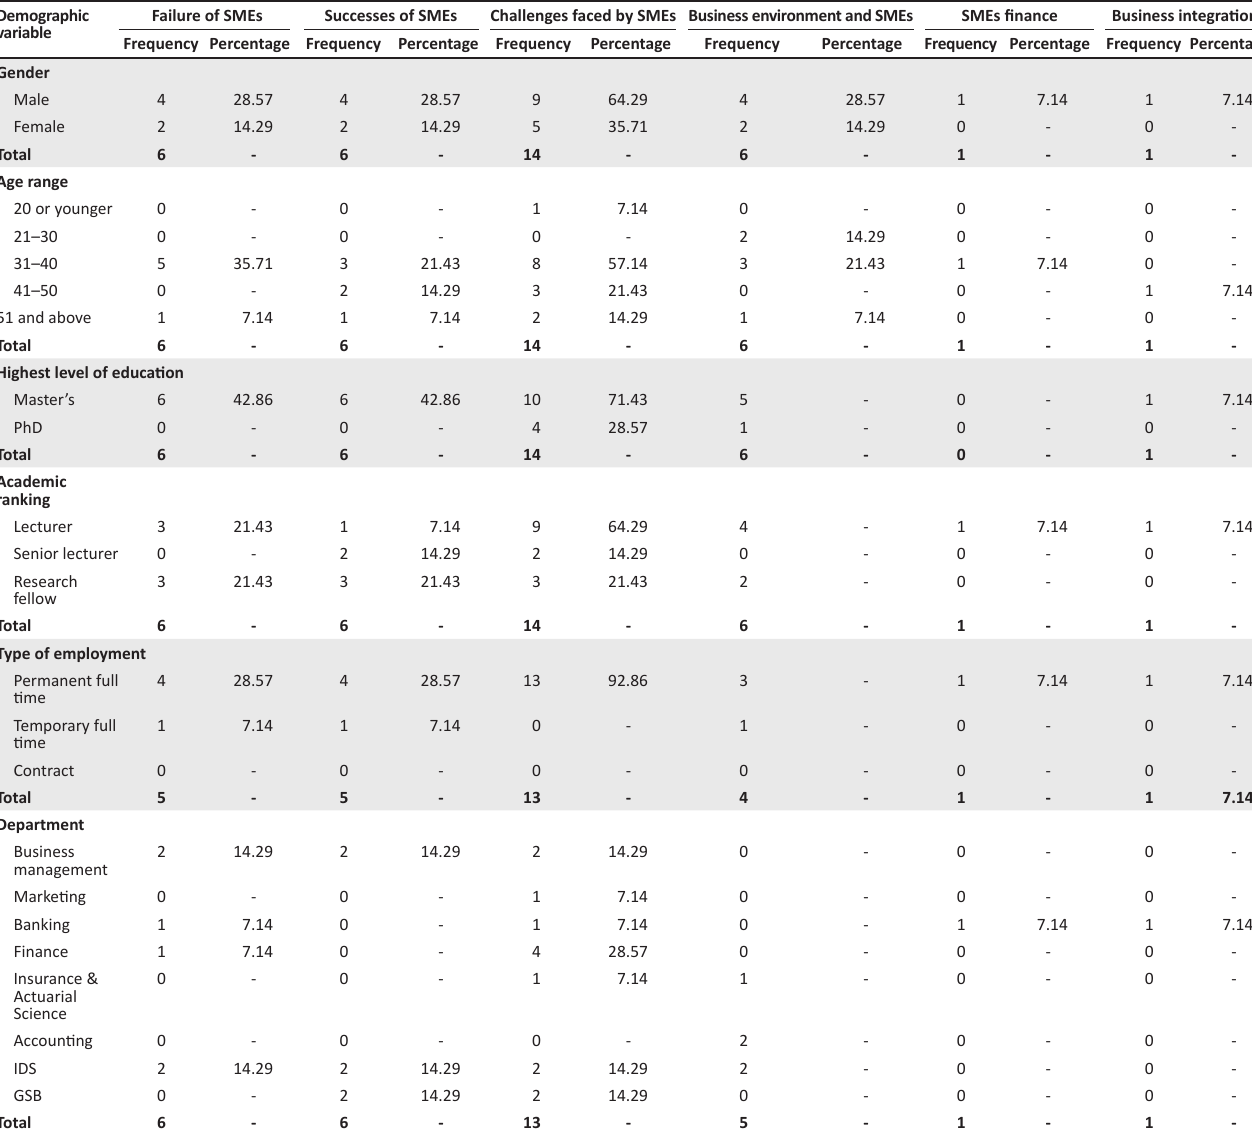
TABLE 2: Areas of focus by all who conducted studies on small and medium enterprises, based on demographic variables ( N = 14). Demographic Failure of SMEs Successes of variable